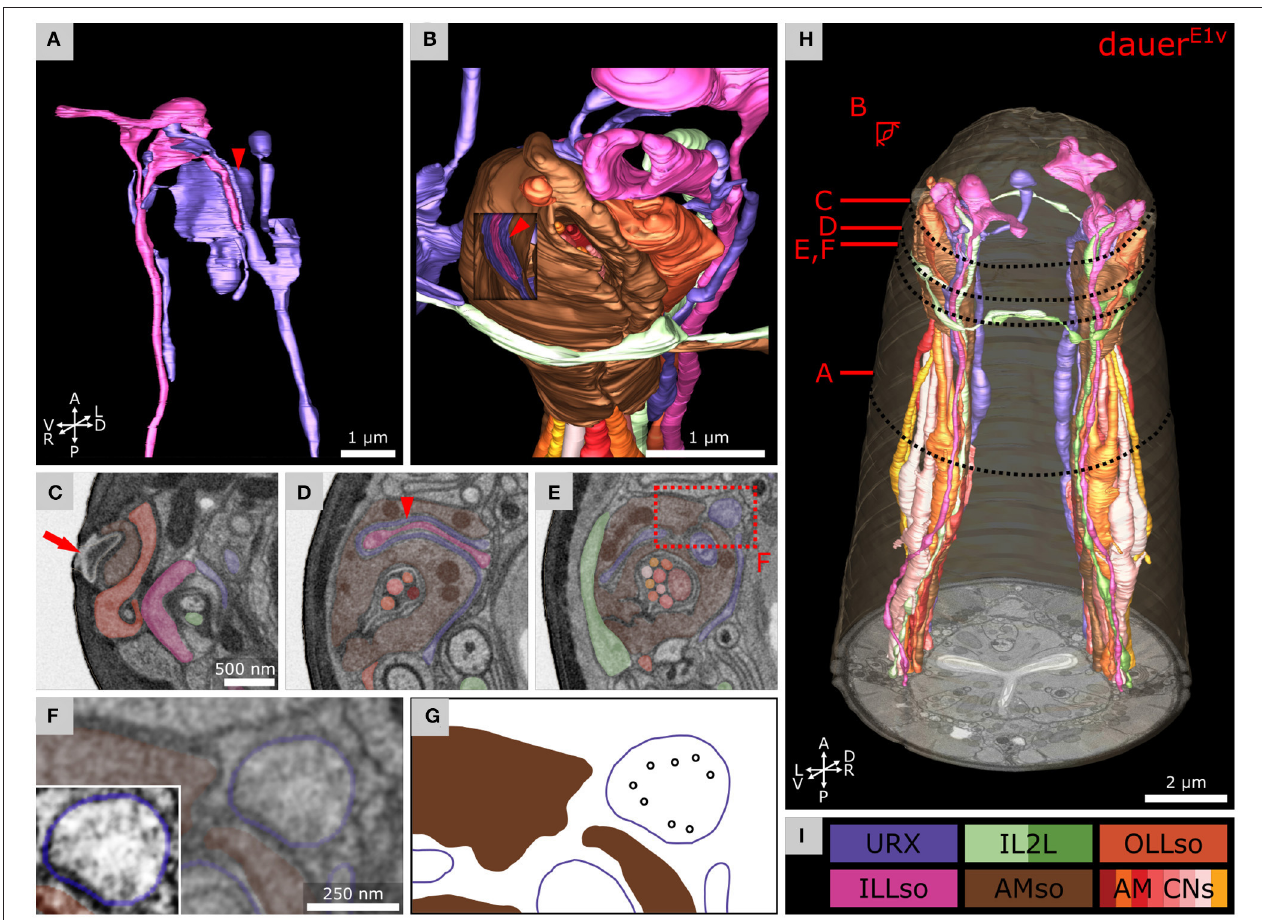
FIGURE 5 | Anterior dendritic endings of dauer URX neurons are putatively ciliated and extend distal structures to enclose ILLso and to be enclosed by AMso support cells. (A) Volumetric 3D reconstruction of URXL sensory ending enclosing a branch of ILLsoL (arrowhead). As an example, the left side is shown. (B) Example of the spatial arrangement of URXL, ILLsoL, AMsoL, OLLsoL, and IL2LL. Part of AMsoL is clipped to allow a view inside. AMsoL encloses the part of URXL which encloses the branch of ILLsoL shown in A (arrowhead). OLLsoL encloses AMsoL at the amphid opening. The crown-like dendrite of IL2LL is in direct contact with AMsoL. (C) Transverse FIB-SEM section at the amphid opening (arrow) in the cuticle, which marks the beginning of the amphid channel formed by AMsoL. AMsoL is enclosed by OLLsoL. (D) Transverse section at the position where AMsoL encloses URXL which encloses ILLsoL (arrowhead). (E) Transverse section at the position where AMsoL encloses URXL but without enclosing ILLsoL. The IL2LL branch passes AMsoL at the periphery. (F) Higher magnified part of E showing microtubules inside URXL. Inset shows the same image with enhanced contrast. (G) Scheme indicating microtubules in F. (H) Overview of reconstruction of all mentioned cell endings. (I) Names and color code of cells